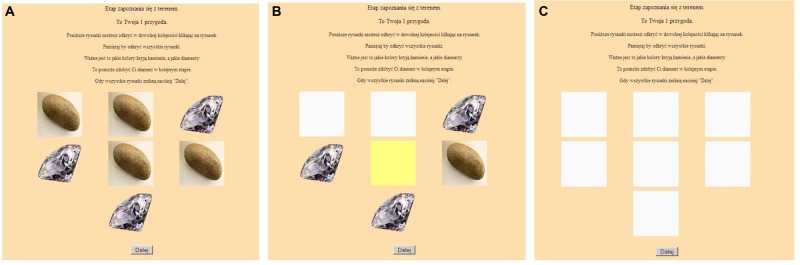
The computer task: the learning stage – (A) before, (B) during, and (C) after turning over the cards.